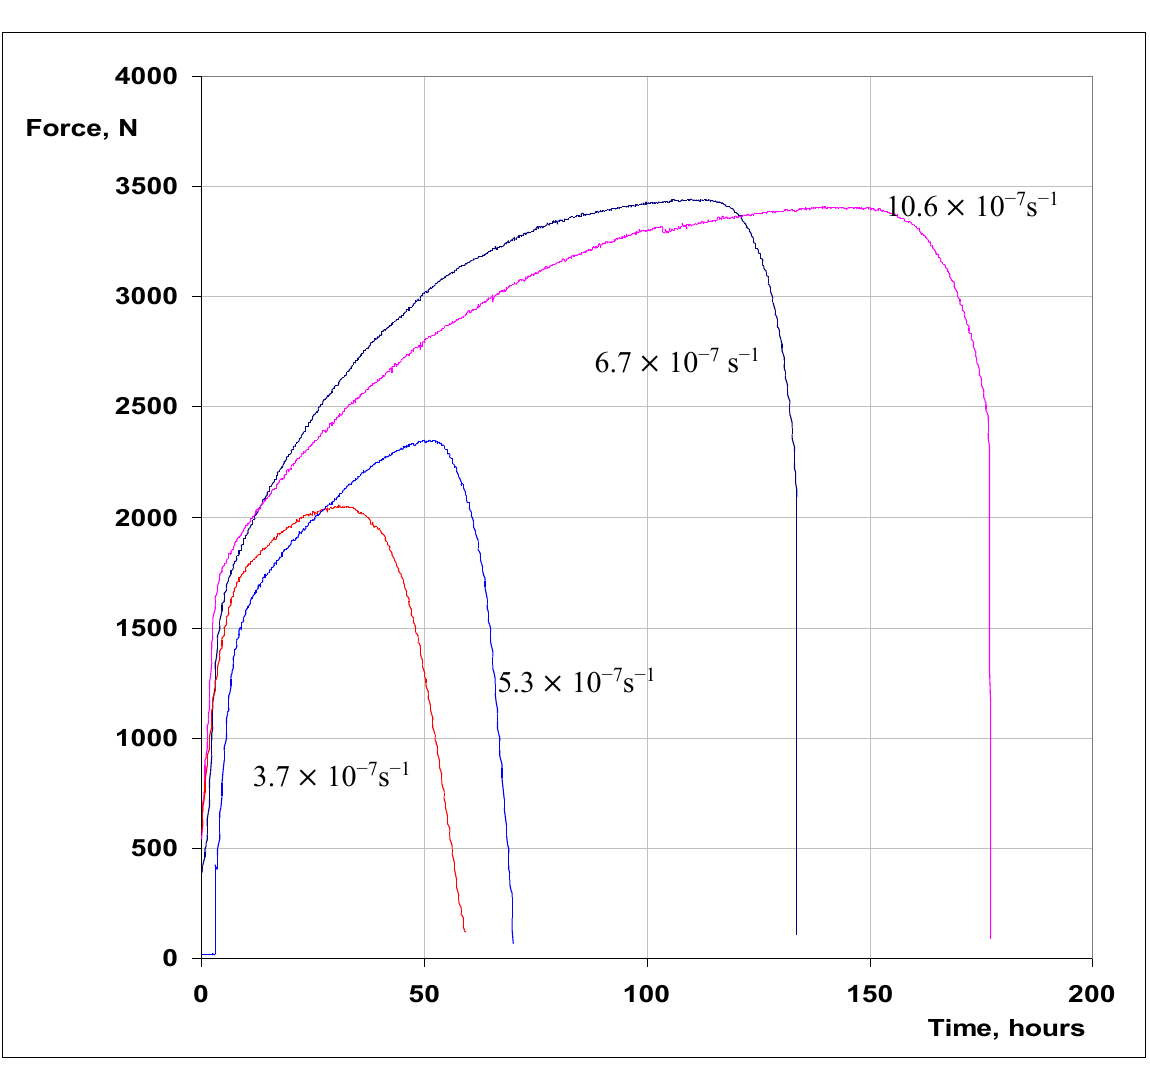
Figure 2. Force vs. time slow strain rate testing (SSRT) curves of 316L in 30 wt. % MgCl 2 at 150 °C, at different strain rates.